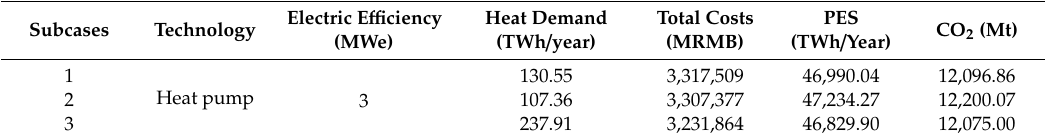
Table 7. Case 3 (Heat Pump) Components Specifications and Summary Performance.